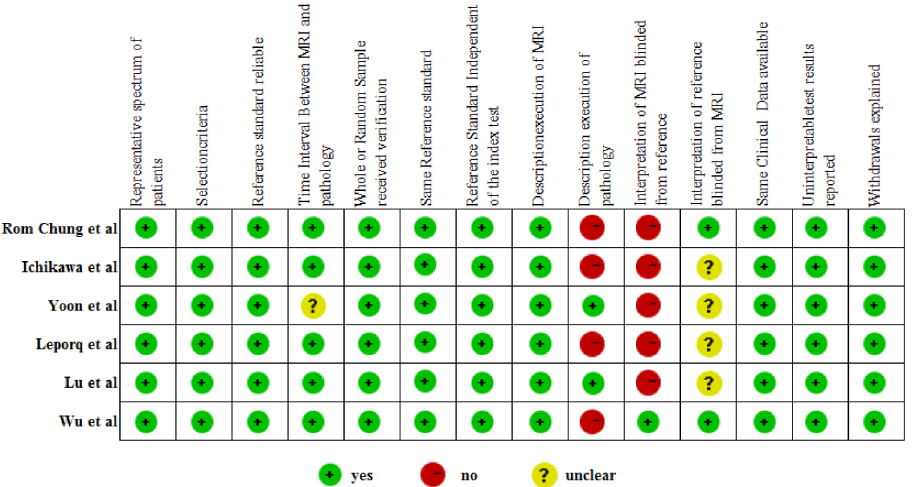
Fig 2. Assessment of quality of included studies using QUADAS